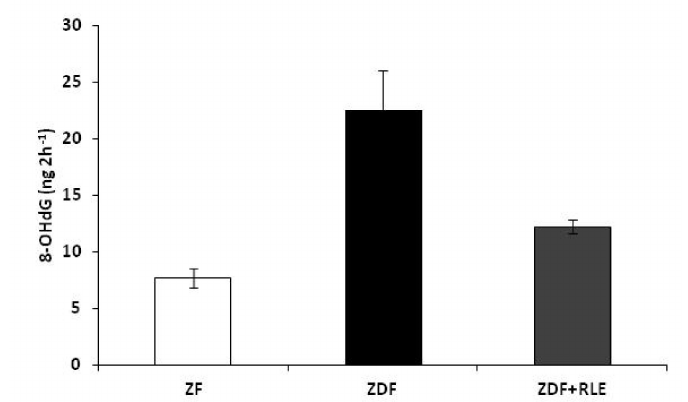
Figure 6. E ff ects of the red orange and lemon extract (RLE) on urinary 8-OHdG concentration, expressed in ng 2 h − 1 , in the Zucker Fatty (ZF), the Zucker Diabetic Fatty (ZDF), and the Zucker Diabetic Fatty + red orange and lemon Extract (ZDF + RLE), after 24 weeks of treatment. Data are shown as mean ± standard deviation (DS) ( n = 6 for each group) and were compared by ANOVA (* p < 0.05 versus ZF, # p < 0.05 versus